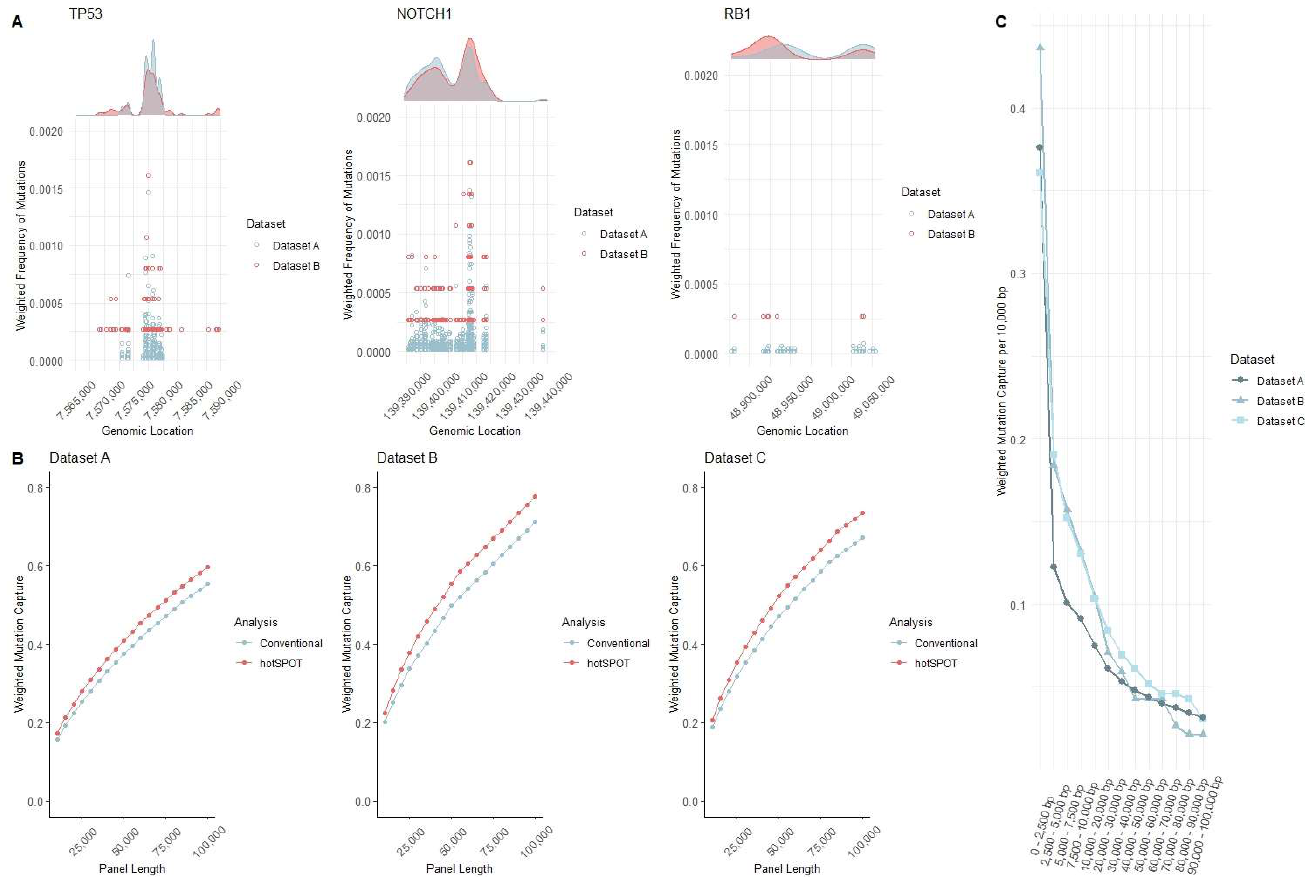
Figure 2. Conceptualization and development of hotSPOT mutation panels. ( A ) Graphical represen- tation of hotspots in frequently mutated (TP53, NOTCH1) and less frequently mutated (RB1) genes in normal skin in datasets A & B. Dots represent the frequency of mutations at each base pair. The plots above represent the density of mutations for each gene. Densities are normalized for each gene based on the average mutation frequency of the datasets. ( B ) Comparison of mutation capture efficacy between conventional and forward hotspot binning methods for Datasets A–C. Mutation capture for each dataset is normalized by the number of mutations present in original analysis. ( C ) Weighted capture efficacy of Datasets A–C ranging from the highest and lowest mutated regions generated by hotSPOT forward binning algorithm.